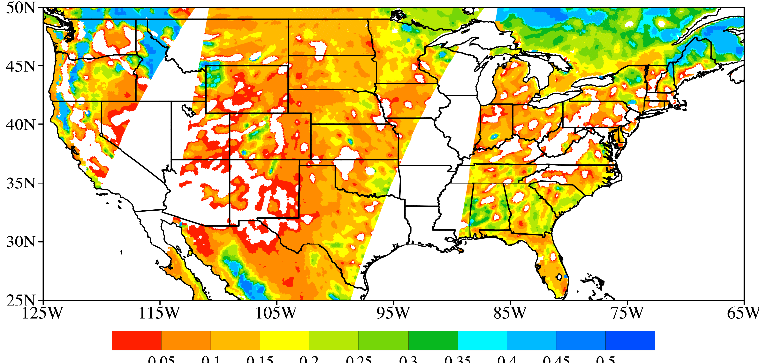
Figure 1. Spatial distribution of the retrieved soil moisture using AMSR-2 vertical polarization channel 1 at 6 GHz on 18 June 2016 with the LPRM.